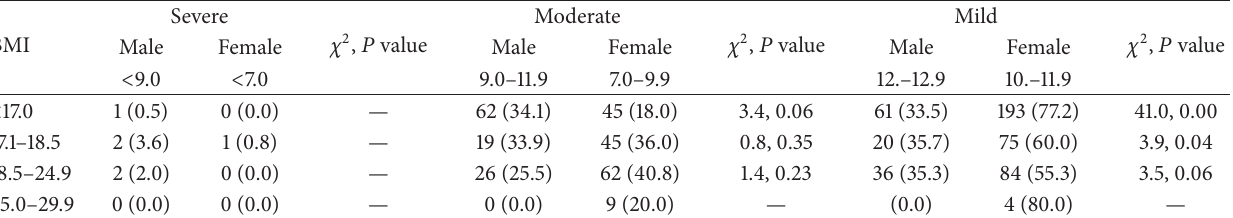
Table 2: Prevalence of anemia (g/dL) as per different BMI (kg/m 2 ) categories among studied adolescent males and females in Himalayan state of north India,